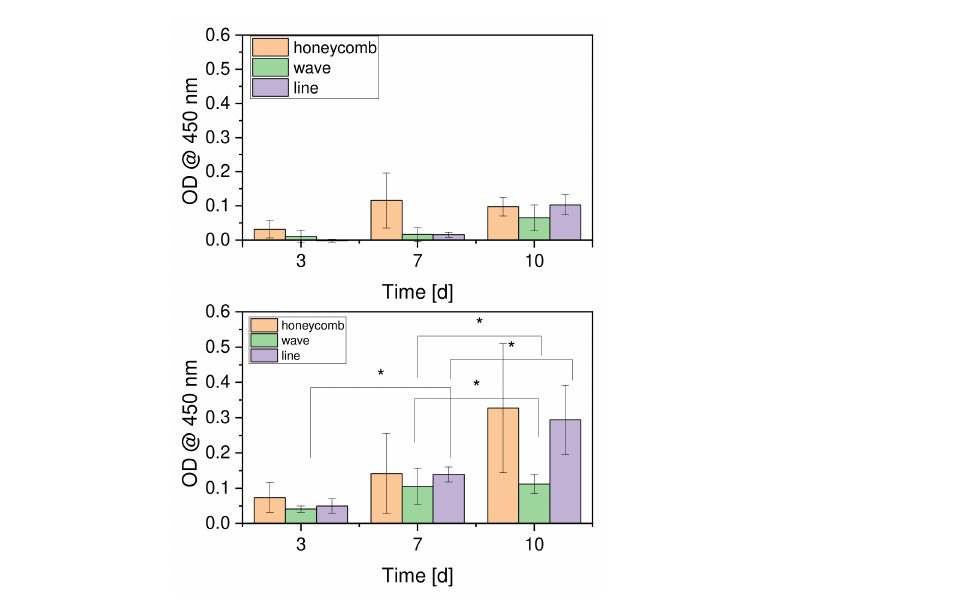
Figure 13. Cell proliferation assay (WST-I). Top: results of the remaining cells in the cell culture plate; bottom: results of the cells on the scaffolds; n = 30; with p < 0.05